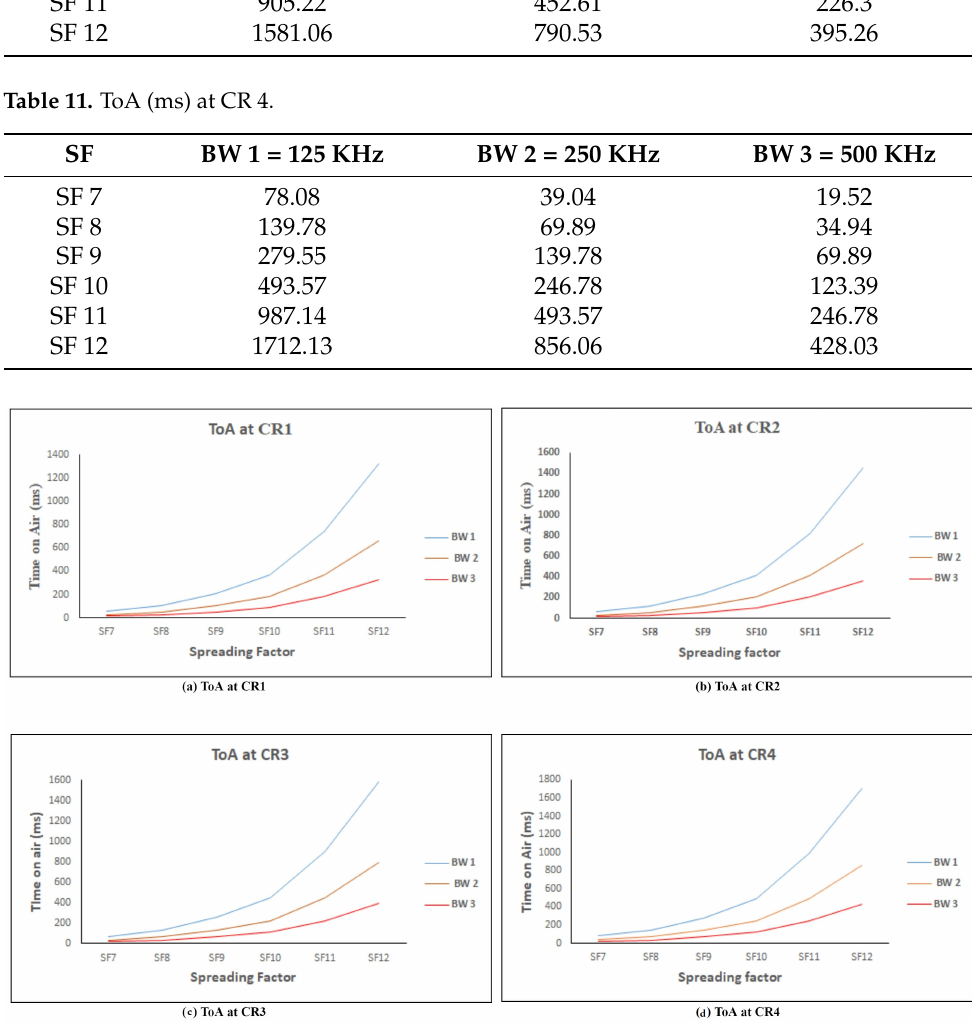
Figure 10. ToA for a payload of 25